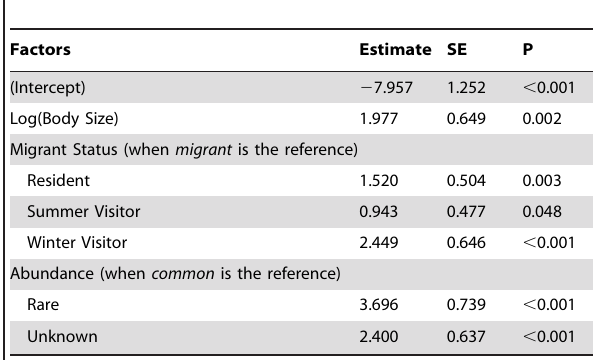
Table 3. Estimate ( 6 SE) of factors that explained variation in the probability of apparent local extinction of bird species in the studied region of China (using a GLMM Laplace procedure (Link = Logit, Binomial) with Genus within Family within Order as three nested random